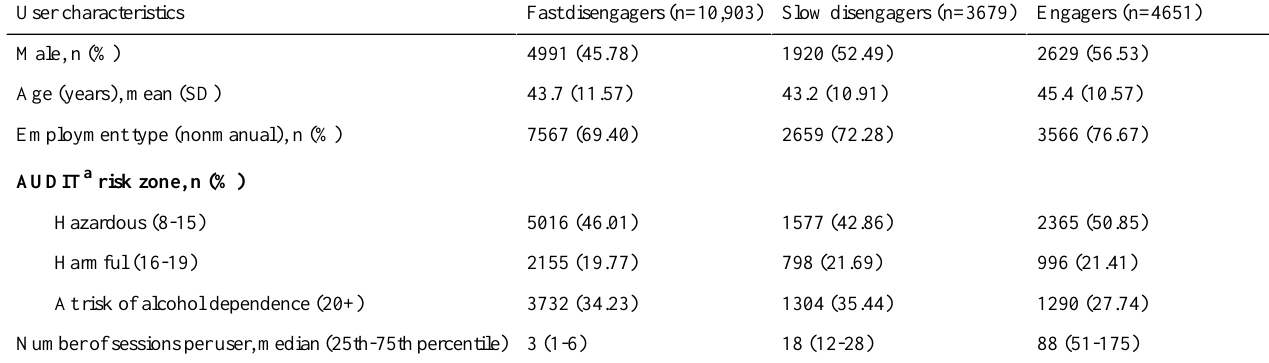
Table 2. User characteristics by cluster